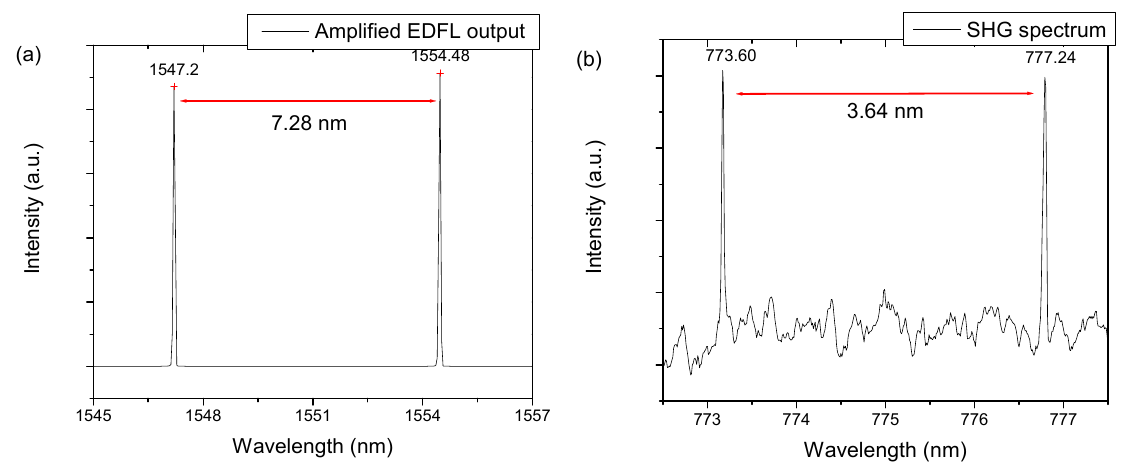
Figure 4. (a) Spectrum of amplified EDFL output as a fundamental NIR beam. (b) Spectrum of converted SHG